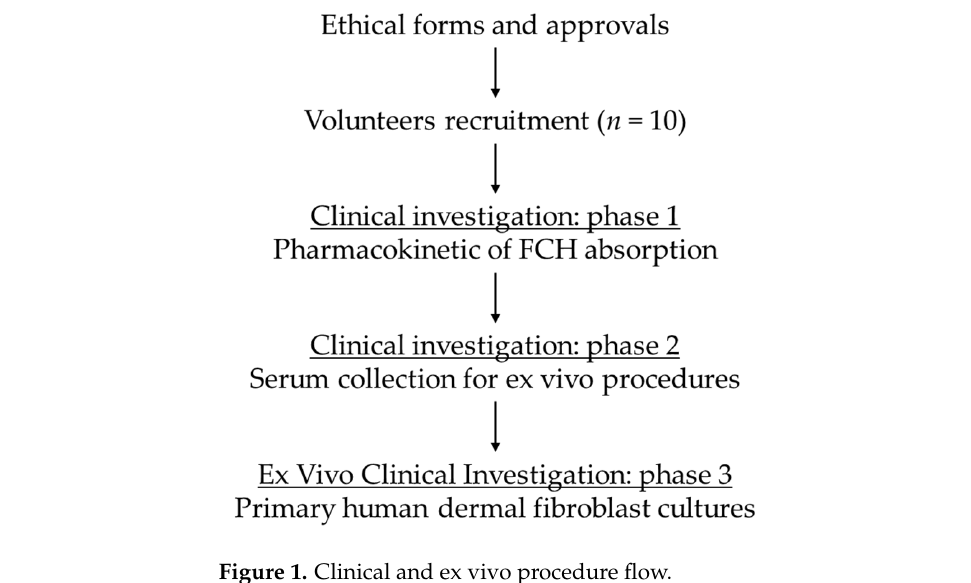
Figure 1. Clinical and ex vivo procedure flow.